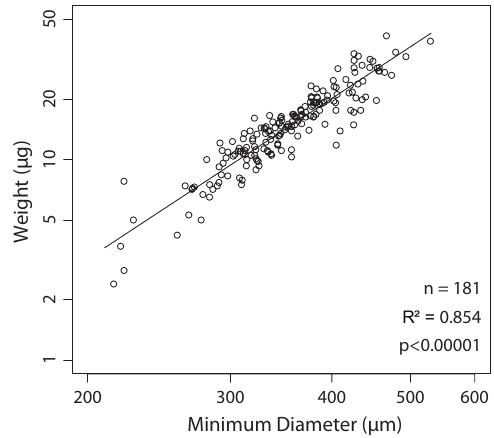
Fig. 4. Correlation between minimum test diameter of A. tepida and shell weight. All individuals measured and weighed during this study are shown (residual standard error = 0.181, exponential fit).